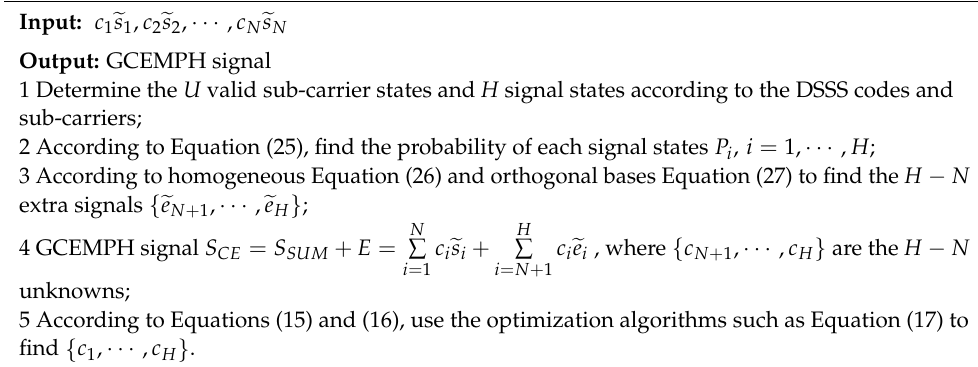
Algorithm 1: General construction based on probability and homogeneous equations